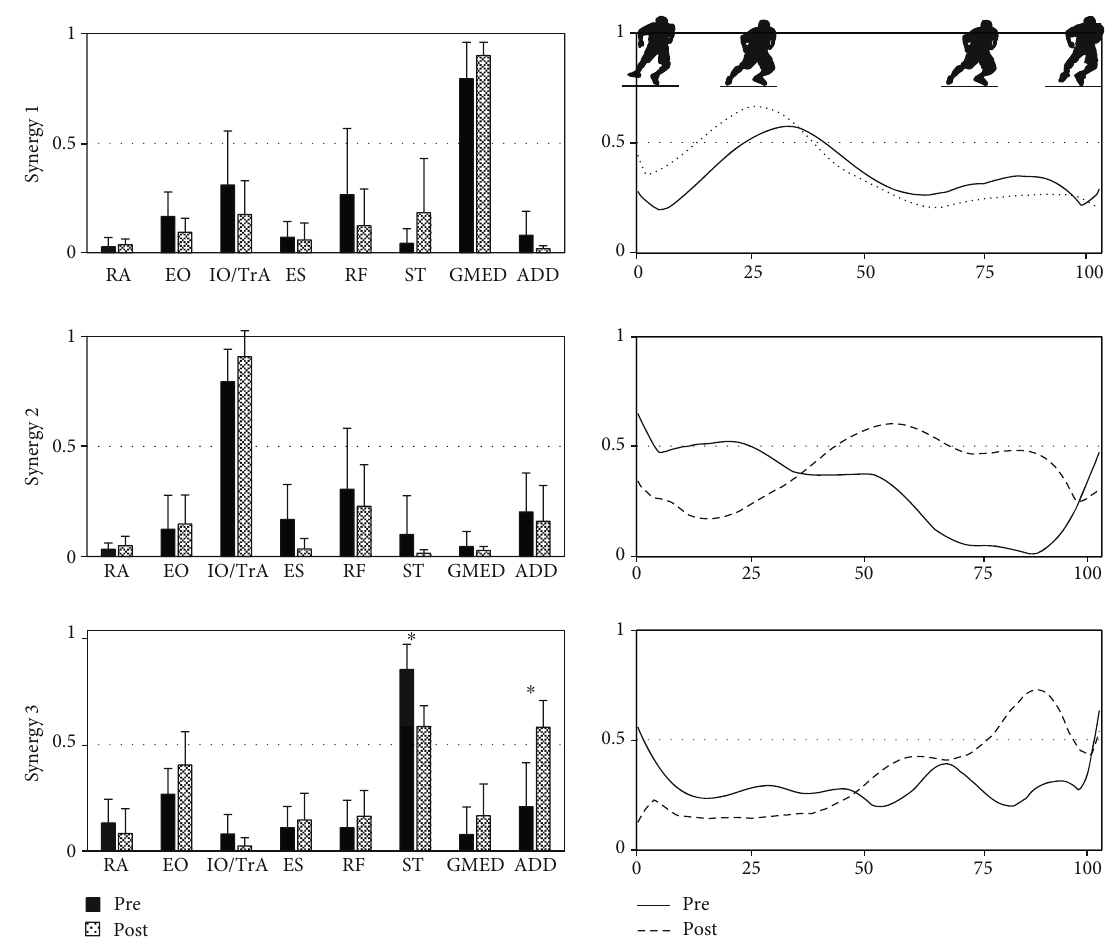
Figure 2: Extracted synergies (left) and the activation pattern (right) during side cutting before and after fatigue. RA: rectus abdominis; EO: external oblique; IO/TrA: internal oblique/transversus abdominis; ES: erector spinae; RF: rectus femoris; ST: semitendinosus; Gmed: gluteus medius; ADD: adductor muscle. ∗ Signi fi cant di ff erence ( P < 0 : 05